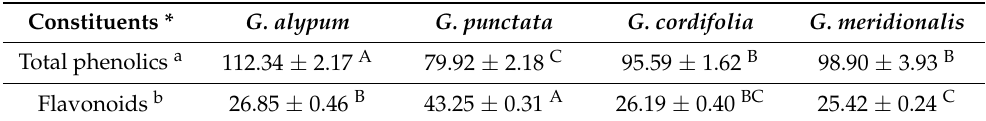
Table 2. Phytochemical content of methanolic aerial parts extracts of G. alypum , G. punctata , G. cordifolia and G. meridionalis obtained by Soxhlet extraction (mean values ± SD, n = 3). Constituents * G. alypum G.